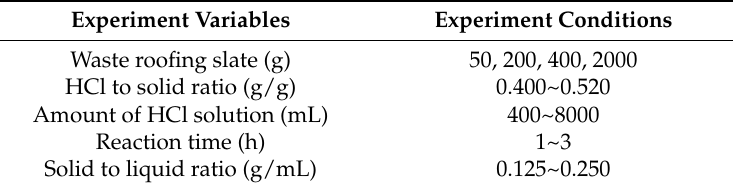
Table 3. Experiment conditions of slate acid treatment test.